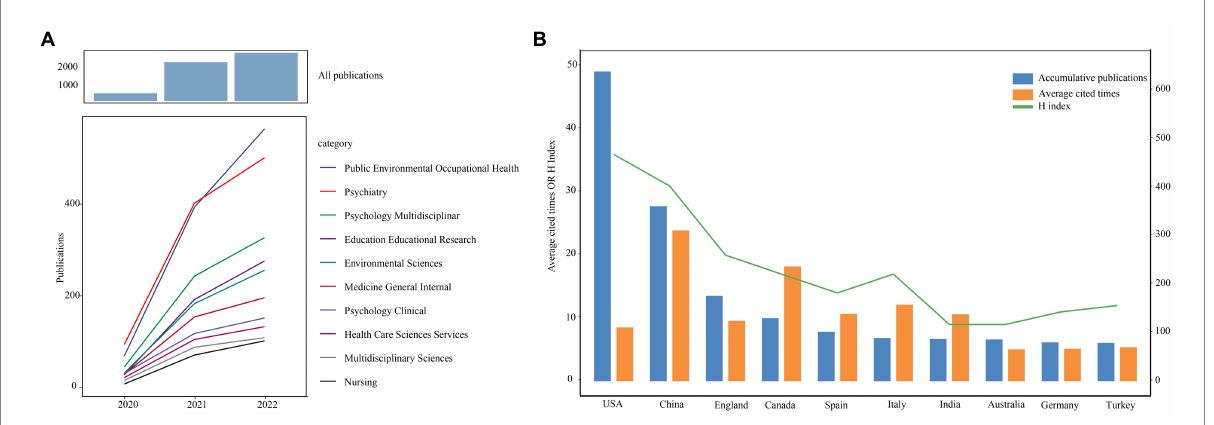
FIGURE 1 The overall distribution of publications. (A) The annual accumulative publications were exhibited by year and discipline. (B) The total number, average cited time and H-index of publications in countries.